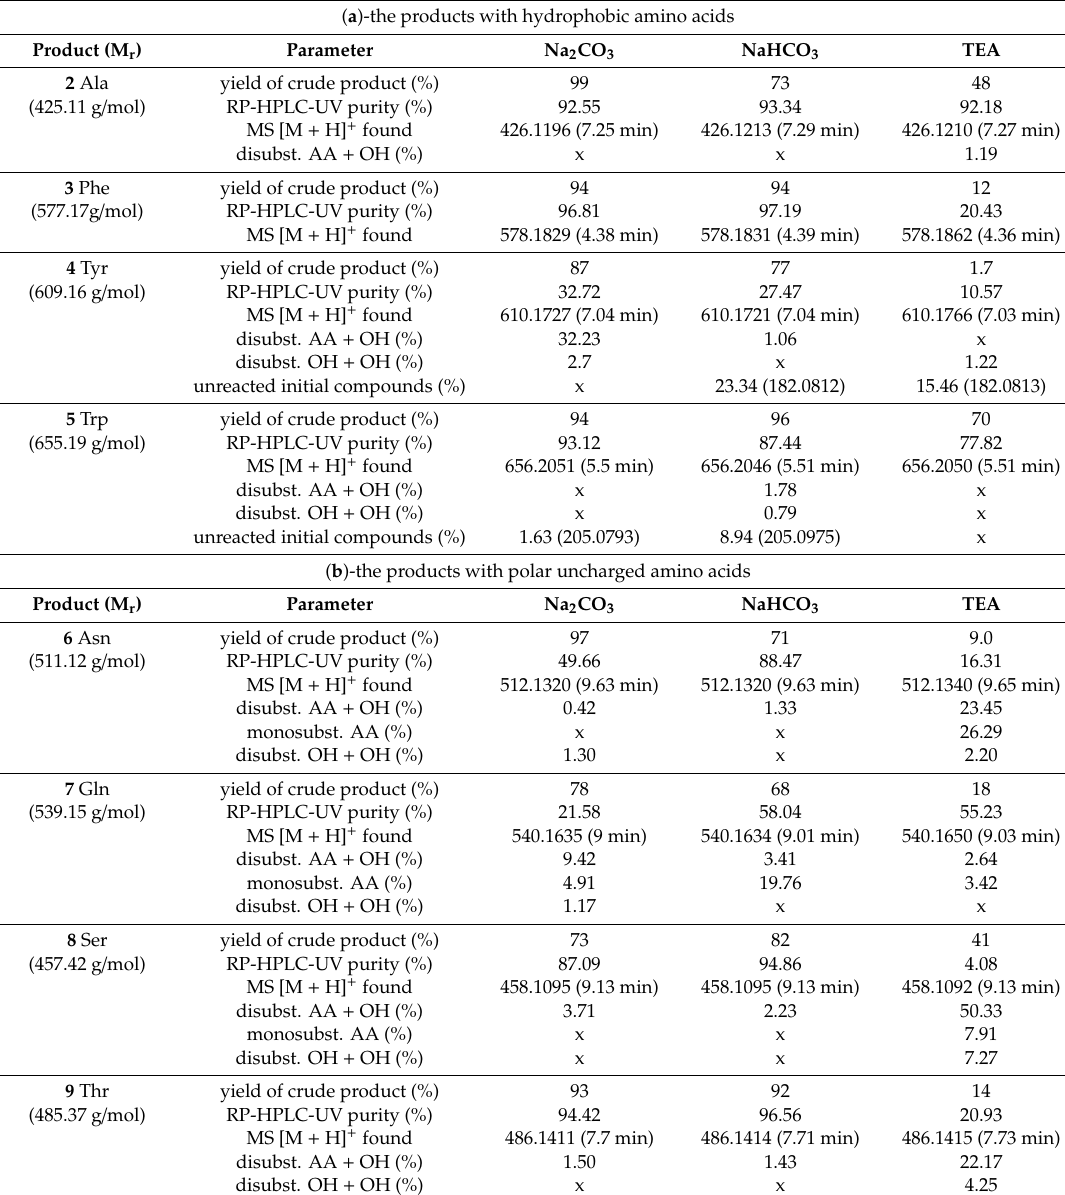
Table 1. Yield, purity, and characteristic impurities of the sulfonamide derivatives with amino acids of various polarities obtained from HPLC-ESI-DAD / QTOF / MS analysis of crude